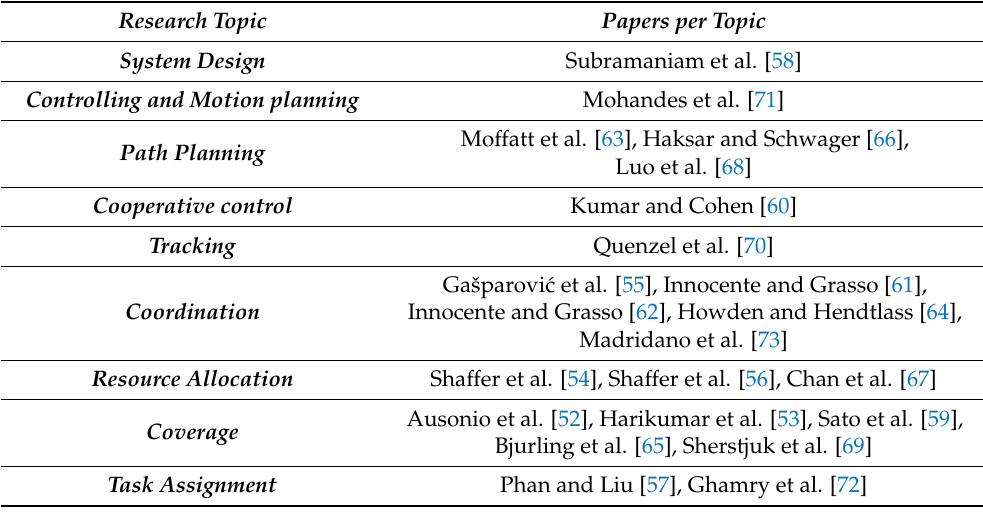
Table 11. Papers reviewed for different research scope using